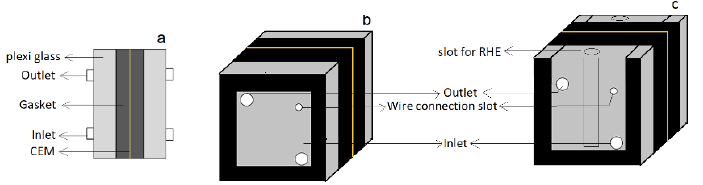
Figure 1. ( a ) Side view of Cell A and Cell B; ( b ) front view of Cell A; ( c ) front view of Cell B.